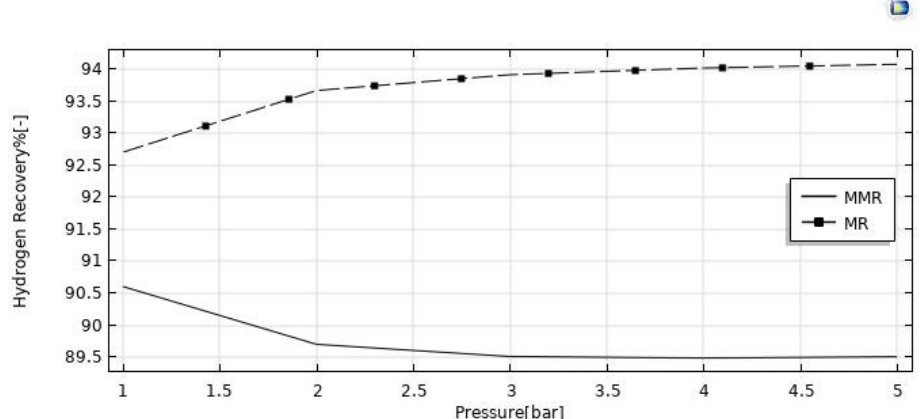
Figure 12. Hydrogen recovery vs. reaction pressure at T = 400 °C, feed flow rate = 20 mm 3 /s, and sweep gas flow rate = 333.33 mm 3 /s.